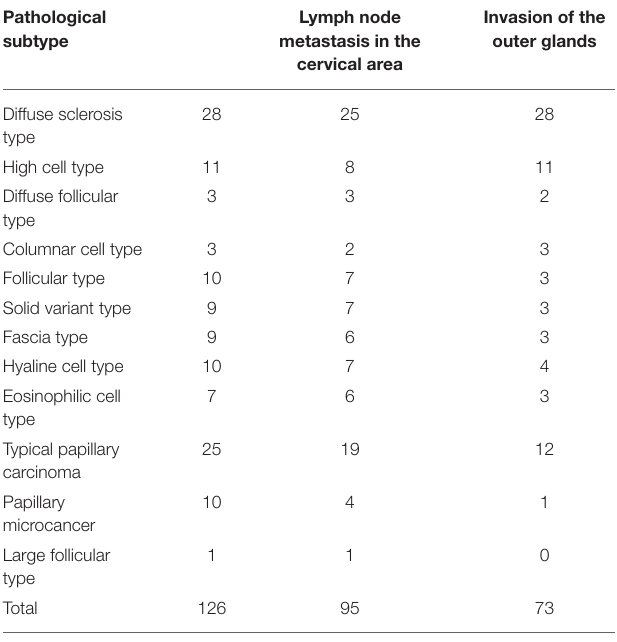
TABLE 2 | Pathological subtype invasion and metastasis of thyroid papillary carcinoma